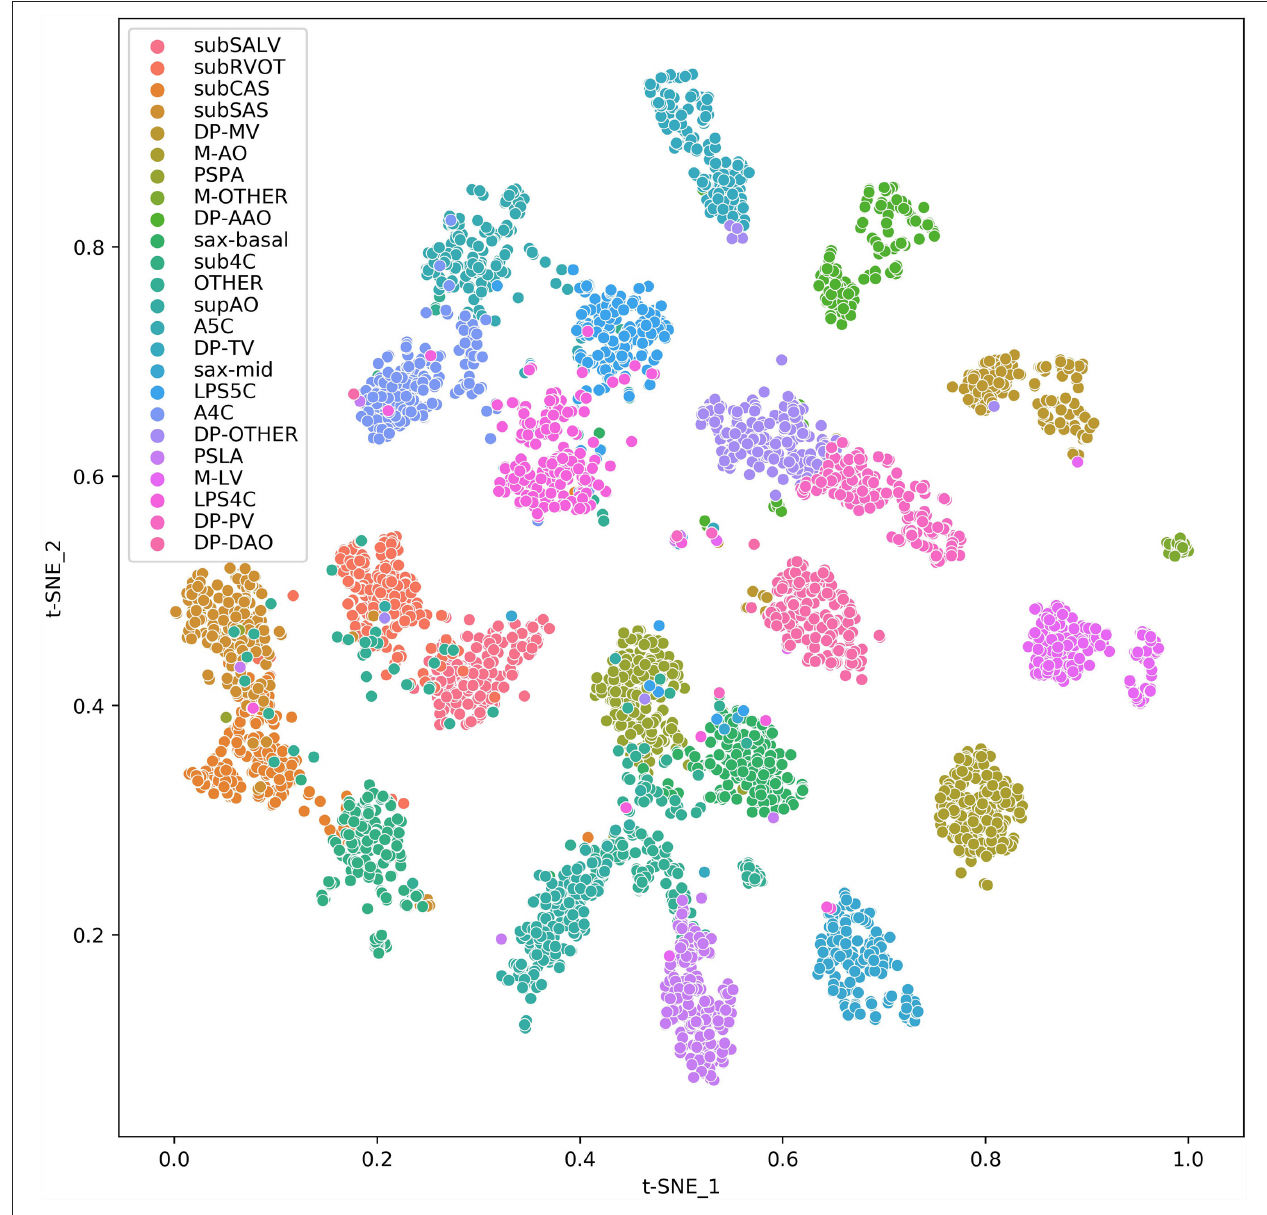
FIGURE 4 | t-SNE visualization of CNN feature clusters for 24 echocardiographic views. Different views are represented with colored clusters and labels. The images are sampled from the test set data and 256 samples were randomly sampled for each view. For views whose total number are < 256, all samples are applied.